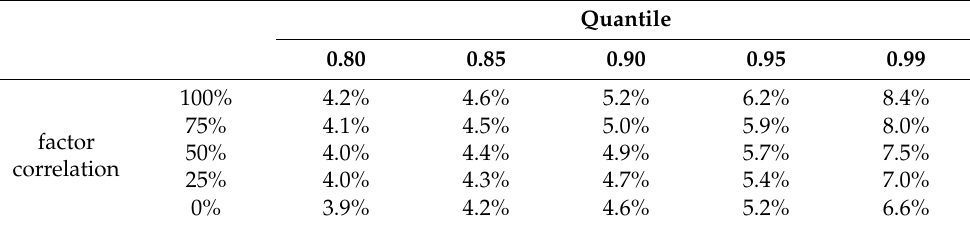
Table 2. Total loss results corresponding to various quantiles and factor